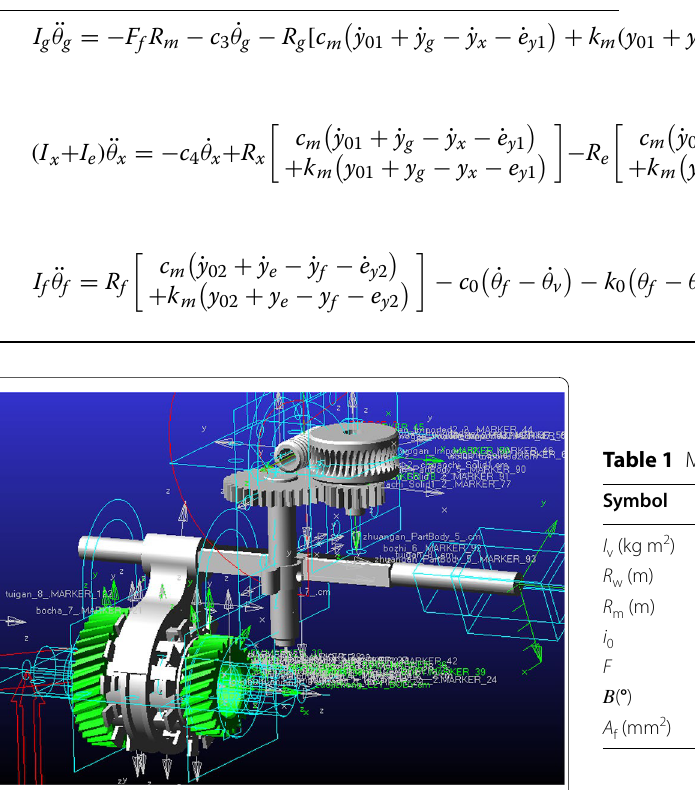
Figure 18 Multi-body dynamics modeling based on ADAMS